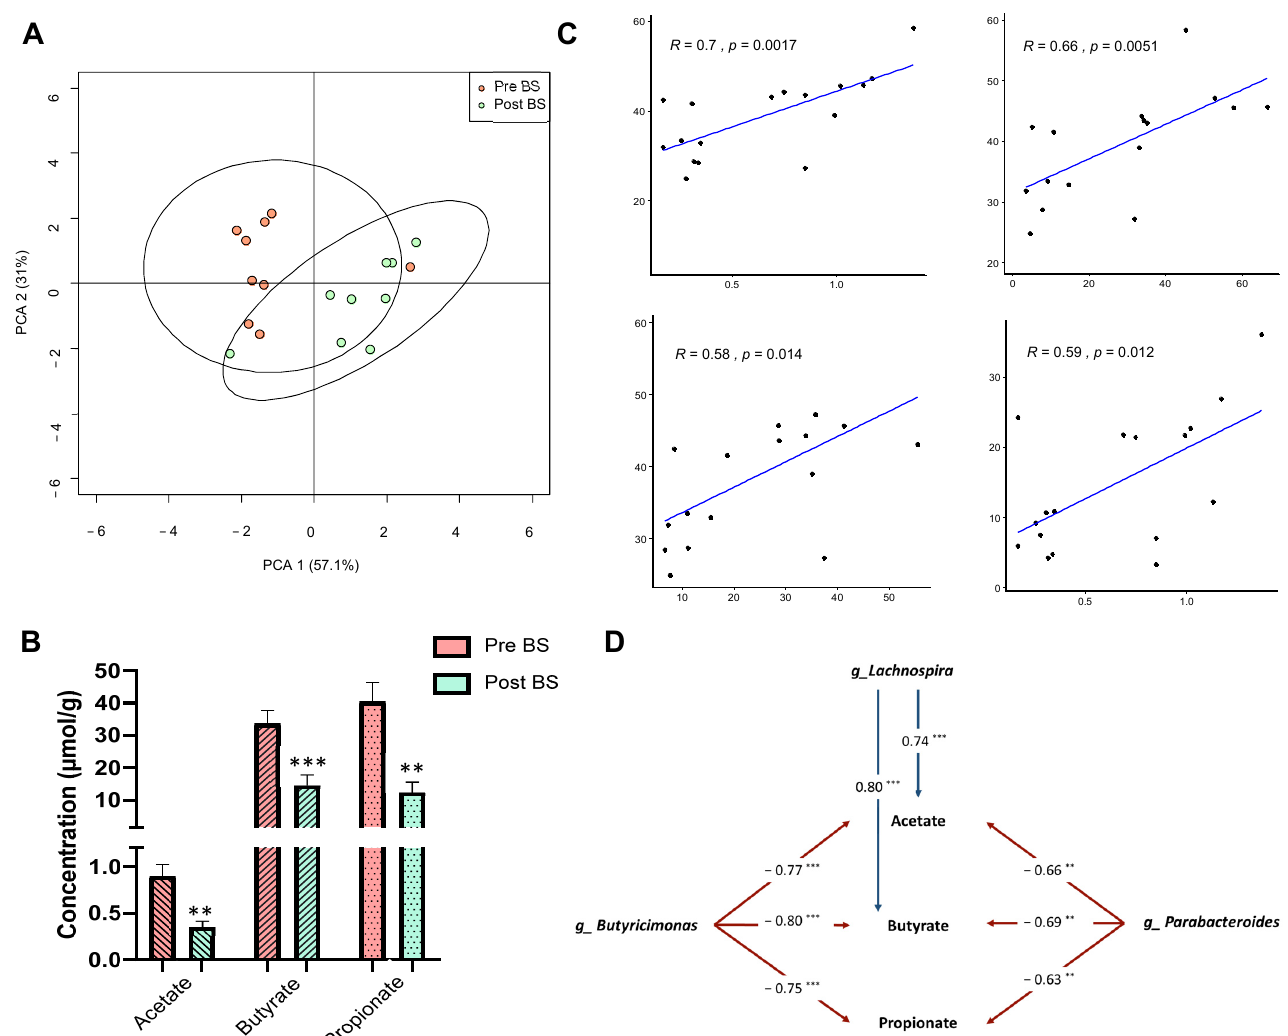
Figure 4. Faecal short-chain fatty acids profile before and after bariatric surgery in patients with severe obesity. ( A ) Principal coordinate analysis (PCA) showing the differences in the faecal short-chain fatty acids profile of patients before (Pre BS) and after (Post BS) bariatric surgery. ( B ) Differences in the faecal concentration ( µ mol/g of faeces) of the main short-chain fatty acids in patients with severe obesity Pre BS and Post BS. Nonparametric Wilcoxon signed-rank test. ** p < 0.01; *** p < 0.01 vs. Pre BS. ( C ) Pearson’s correlation coefficients and linear relationships of the main short-chain fatty acids (acetate, butyrate and propionate) and the biochemical and anthropometric parameters. ( D ) Associations of gut microbiota composition with the main short-chain fatty acids (acetate, butyrate and propionate). The values in arrows represent Spearman’s correlation coefficients of each pair of parameters. ** p < 0.01; *** p < 0.01. Detailed XY representation of each association is provided in Figure